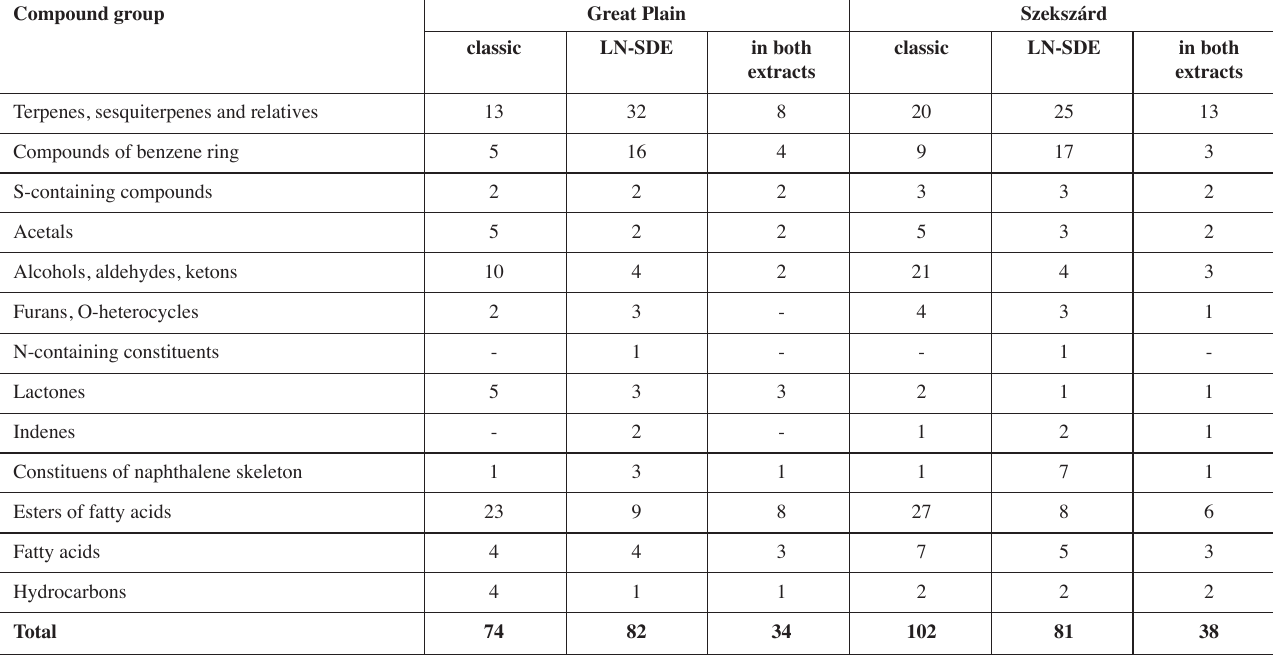
Tab. 1: The number of the identified compounds in Kadarka wines Compound